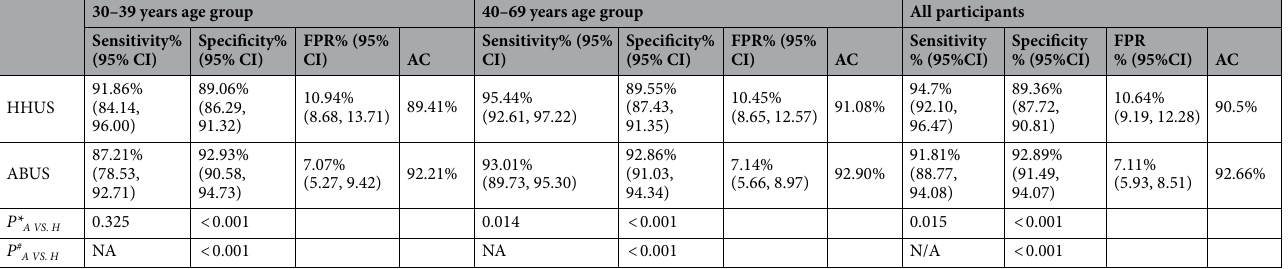
Table 5. General non-inferiority and superiority study between HHUS and ABUS. *Non-inferiority P value; # superiority P value; FPR: false positive rate; AUC: area under curve; AC: